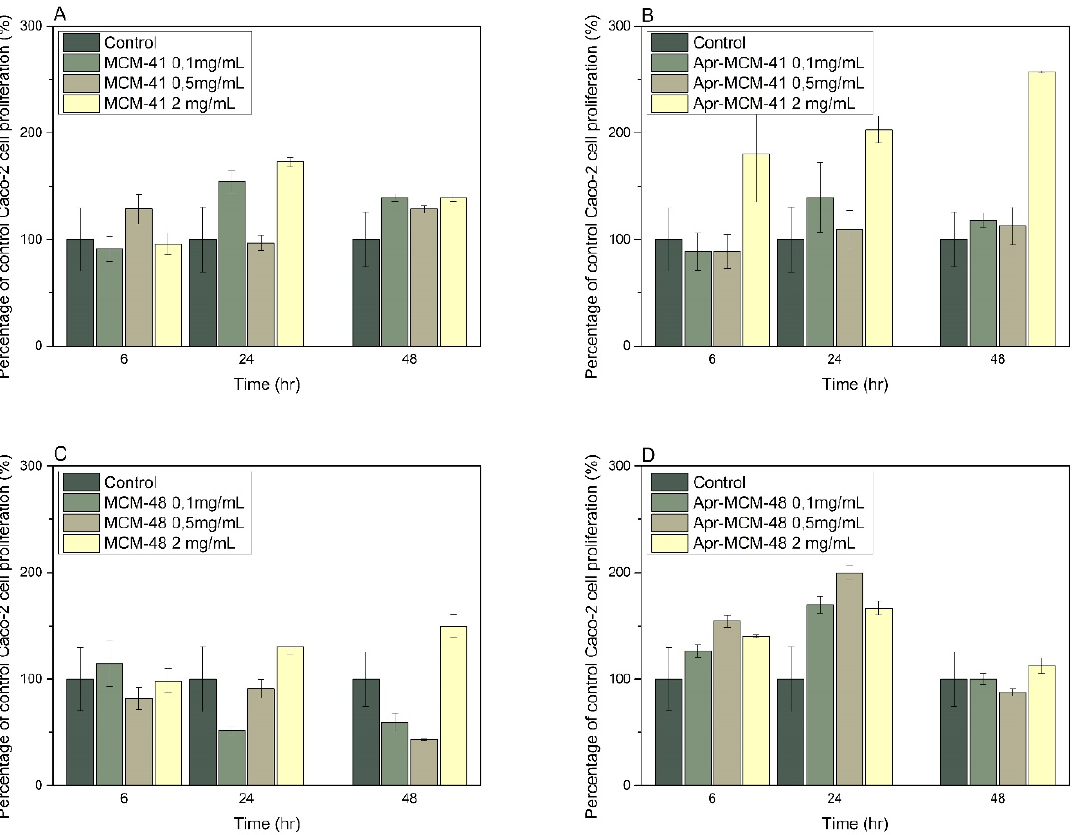
Figure 11. Cell growth assessment of Caco-2 cells incubated for 48 h with increasing concentrations of ( A ) MCM-41, ( B ) aprepitant-loaded MCM-41, ( C ) MCM-48, and ( D ) aprepitant-loaded MCM-48 particles.